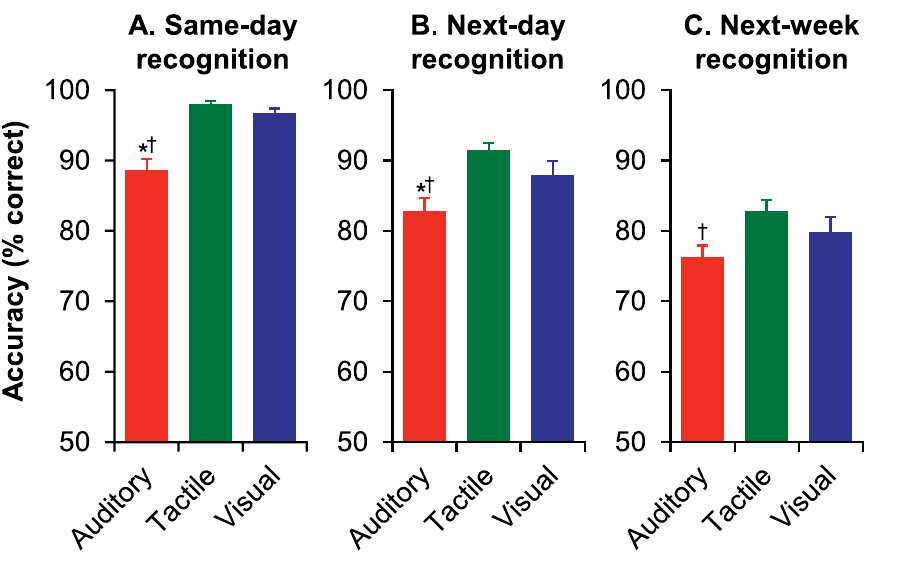
Figure 2. Experiment 2: Mean ( + SEM) recognition accuracy among sensory modalities for complex, naturalistic stimuli. (A) When tested immediately after the study phase, recognition accuracy was lower for auditory stimuli than visual or tactile stimuli. (B) Similarly, recognition was lower for auditory stimuli when tested 24 hours after the study phase. (C) When tested one week after the study phase, recognition accuracy was significantly lower for auditory stimuli than tactile stimuli, but the difference between auditory and visual recognition was not significant. Post-hoc tests ( p , .05; Bonferroni correction): *Accuracy in the auditory block significantly lower than the tactile block. { Accuracy in the auditory block significantly lower than the visual block.